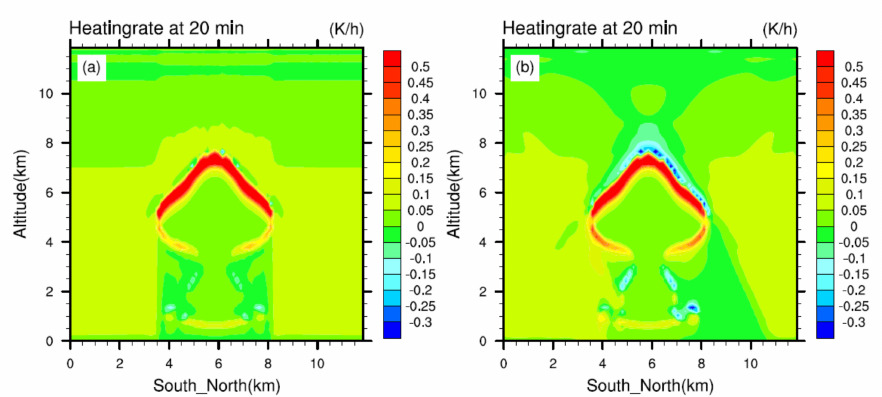
Figure 10. Heating rate in the 1D radiation case ( a ) and the 3D radiation case ( b